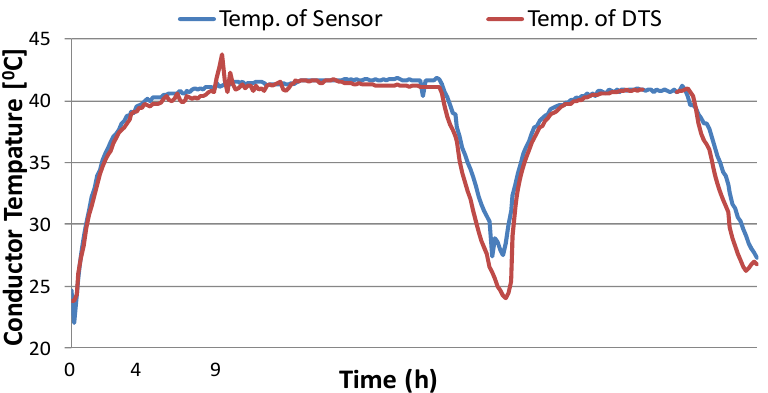
Figure 14. Graph of conductor temperature using a sensor and